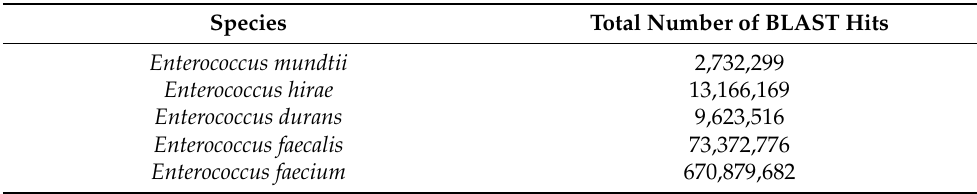
Figure 4. BAGEL4 outputs for gut isolates active against F. nucleatum and/or C. difficile . Three bacterial isolates recovered from WCA underwent whole-genome sequencing and taxonomy assignment using GTDB-Tk software. Putative bacteriocin gene clusters were annotated and predicted using the BAGEL4 software. Figure created with (https://BioRender.com, accessed on 15 February 2022). Table 4. The total amount of BLAST that aligned to the Enterococcus spp. pangenomes, recovered from targeted